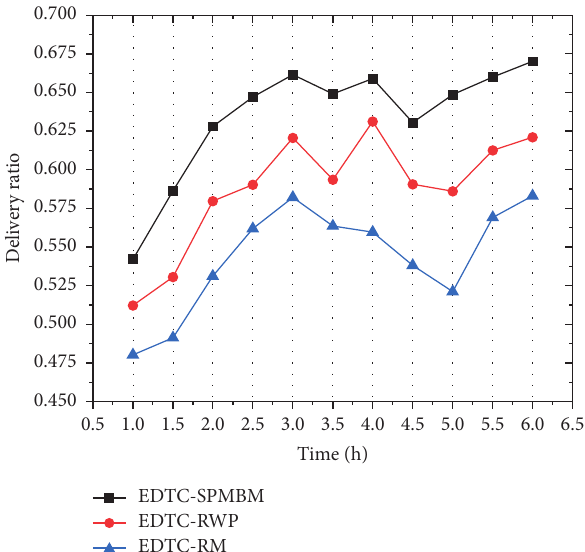
Figure 22: Relationship between energy consumption and time in three mobile models.